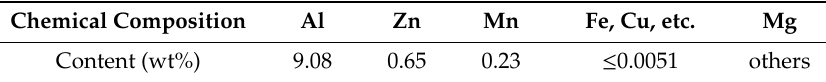
Table 1. Compositions of impurities in AZ91D magnesium alloy.